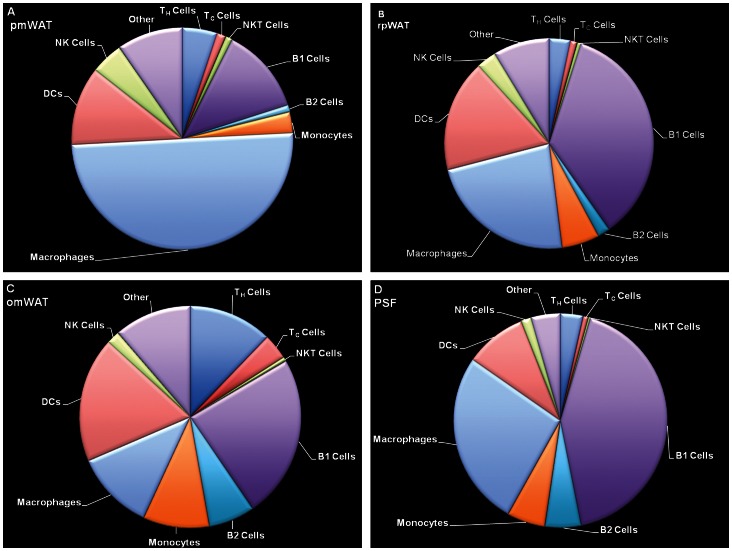
Flow cytometric analysis of leukocyte populations in the SVF of (A) pmWAT, (B) rpWAT, (C) omWAT and (D) PSF.Natural killer (NK) cells include mNKs and preNKs, dendritic cells (DC) include DC (I) from R1 and DC (II) from R2, macrophages include large (LPMs) and small (SPM) peritoneal macrophages, monocytes include monocytes (I) (CD11b+F4/80−) and monocytes (II) (CD11bloF4/80−) populations, and “other” includes regulatory T cells (Treg), CD3+CD4−CD8−NK1.1− subset, and myeloid precursors from R1, as well as neutrophils (PMNs), and pre-B or –macrophage cells (PreBoMs) from R2.